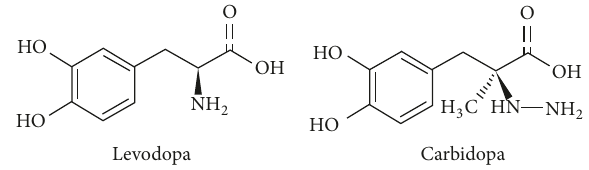
Figure 1: The chemical formulas of Parkinson’s drugs.